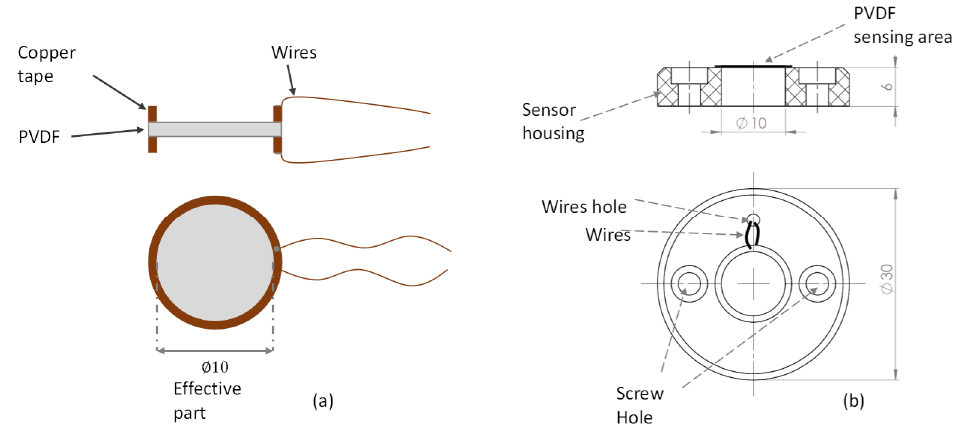
Figure 3. The in-house pressure sensor. ( a ) Illustration of the wired polyvinylidene fluoride PVDF unit; ( b ) drawing of the sensor and the housing.